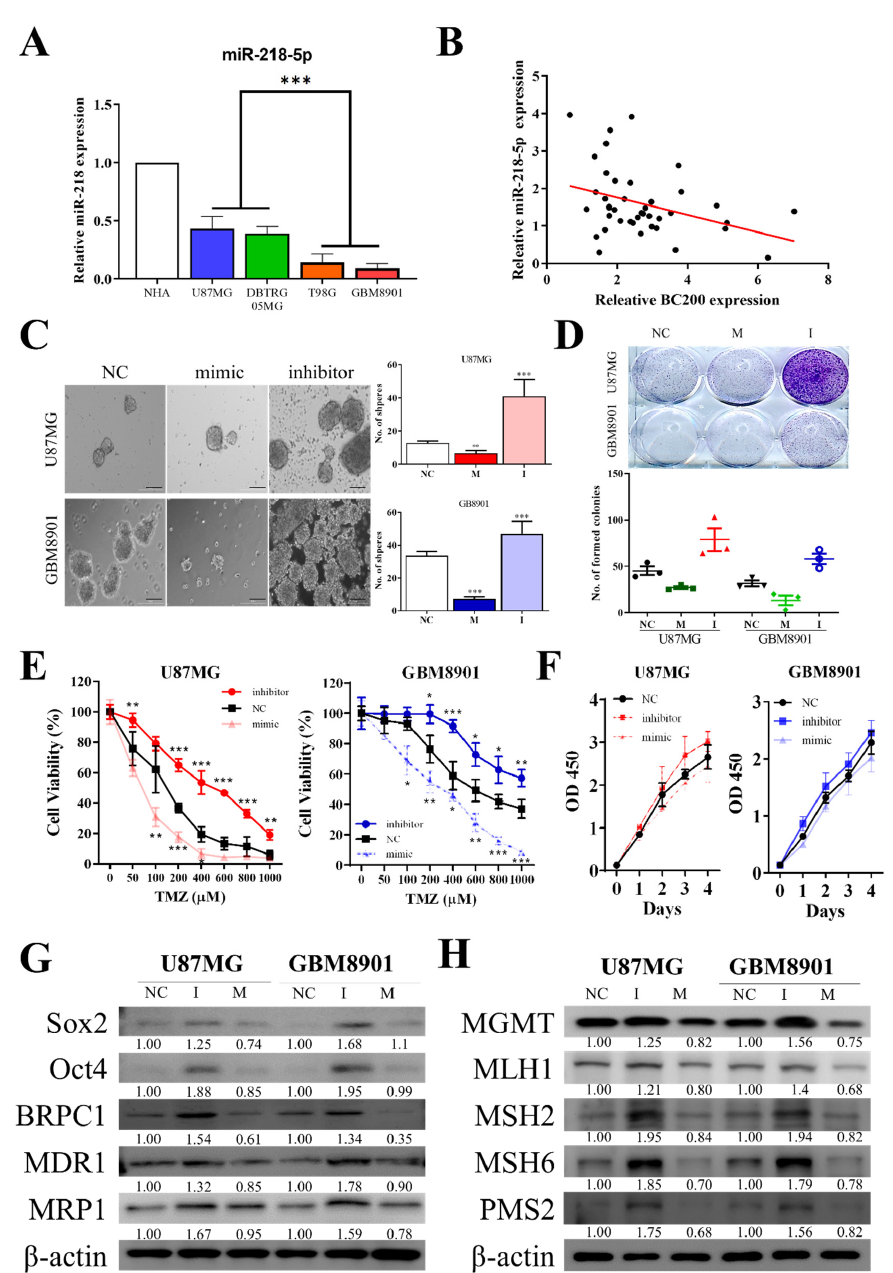
Figure 6. miR-218-5p regulated cell sphere formation, colony formation, and TMZ resistance in GB cells in vitro. ( A ) The di ff erential expression of miR-218-5p in GB cell lines and normal human astrocytes. ( B ) Pearson’s correlation curve identified a negative correlation between BC200 and miR-218-5p in GB tissues. ( C ) Sphere formation assays showed that inhibition or mock transfection of miR-218-5p regulated GB cell stemness. ( D ) Colony formation assays showed that inhibition or mock transfection of miR-218-5p regulated GB cell survival. ( E ) The viability of GB cells with inhibition or mock transfection of miR-218-5p was analyzed through SRB assay 48h after TMZ (0–1000 µ M) treatment. ( F ) CCK-8 assay showed that inhibition or mock transfection of miR-218-5p had no e ff ect on GB cell proliferation. ( G ) The protein levels of SOX2, Oct4, BRPC1, MRP1 and MDR1 with inhibition or mock transfection of miR-218-5p. ( H ) The protein levels of MGMT, MLH1, MSH2, MSH6 and PMS2 following inhibition or mock transfection of miR-218-5p in GB cells were determined through western blot. * p < 0.05, ** p < 0.01 and *** p <